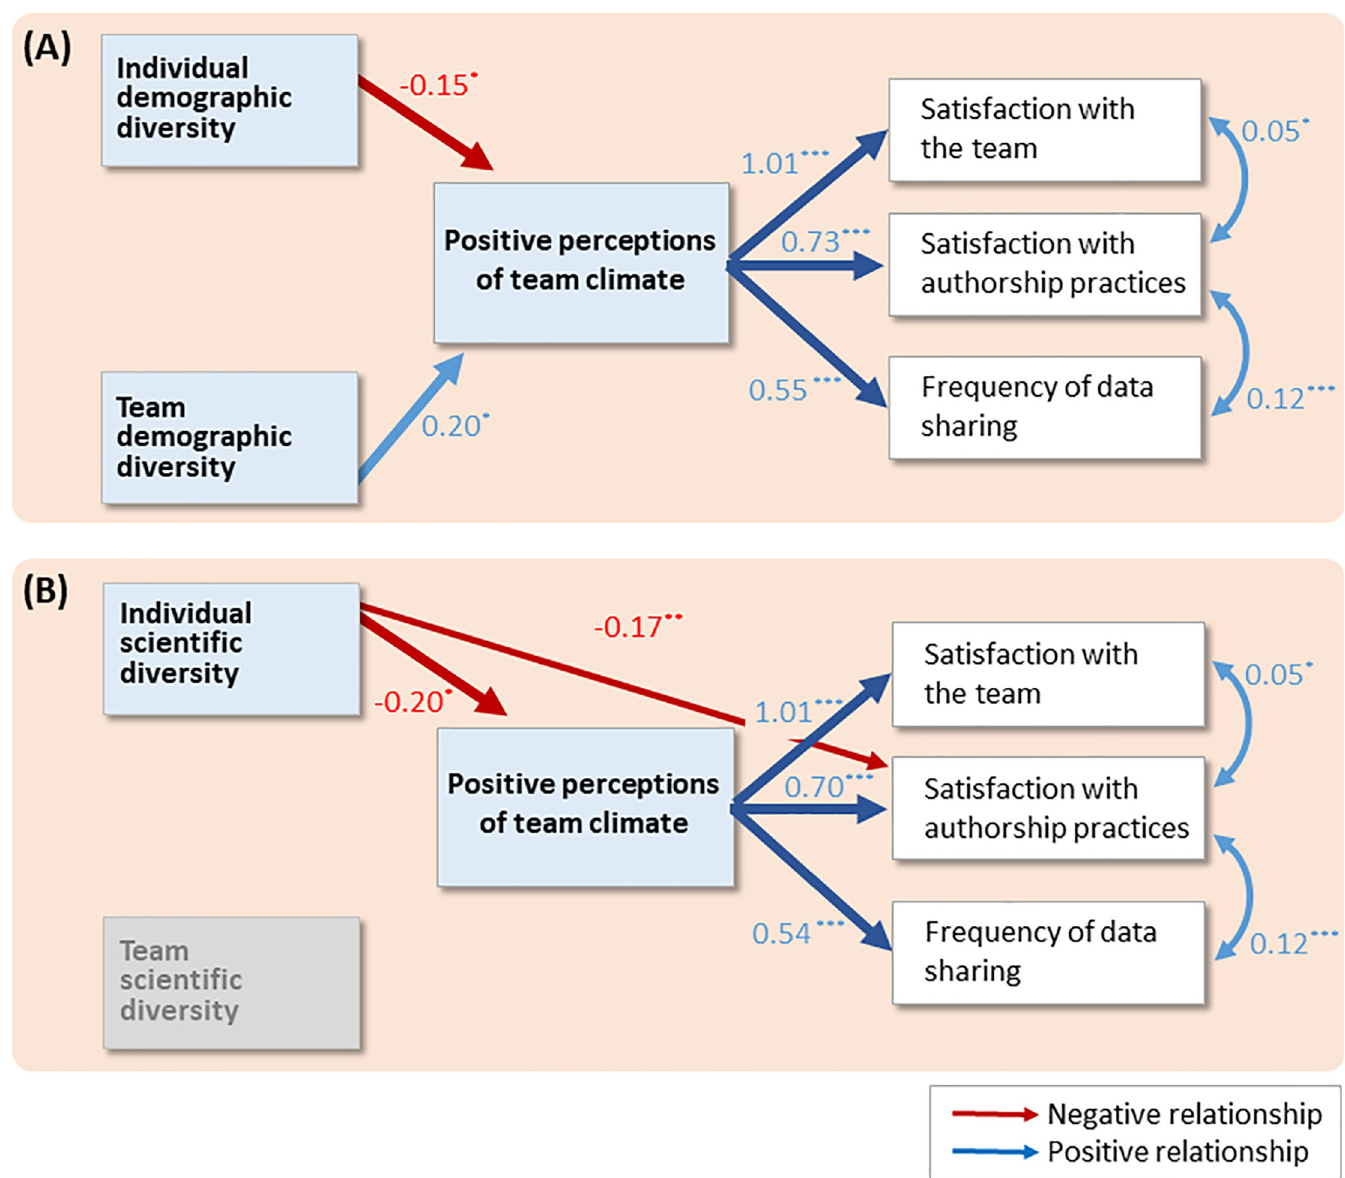
Fig 4. Path analysis results. Individual and team a) demographic diversity and b) scientific diversity effects on environmental science team outcomes, as mediated by climate perceptions. Numbers next to arrows indicate the coefficients, and asterisks show level of statistical significance ( � p < .05, �� p < .01, ��� p < .001); only significant paths are